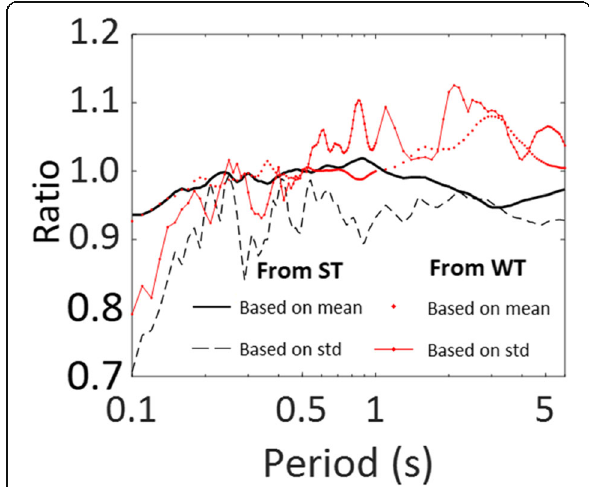
Fig. 12 Ratio of statistics of SA of simulated records with non- Gaussian and Gaussian distribution